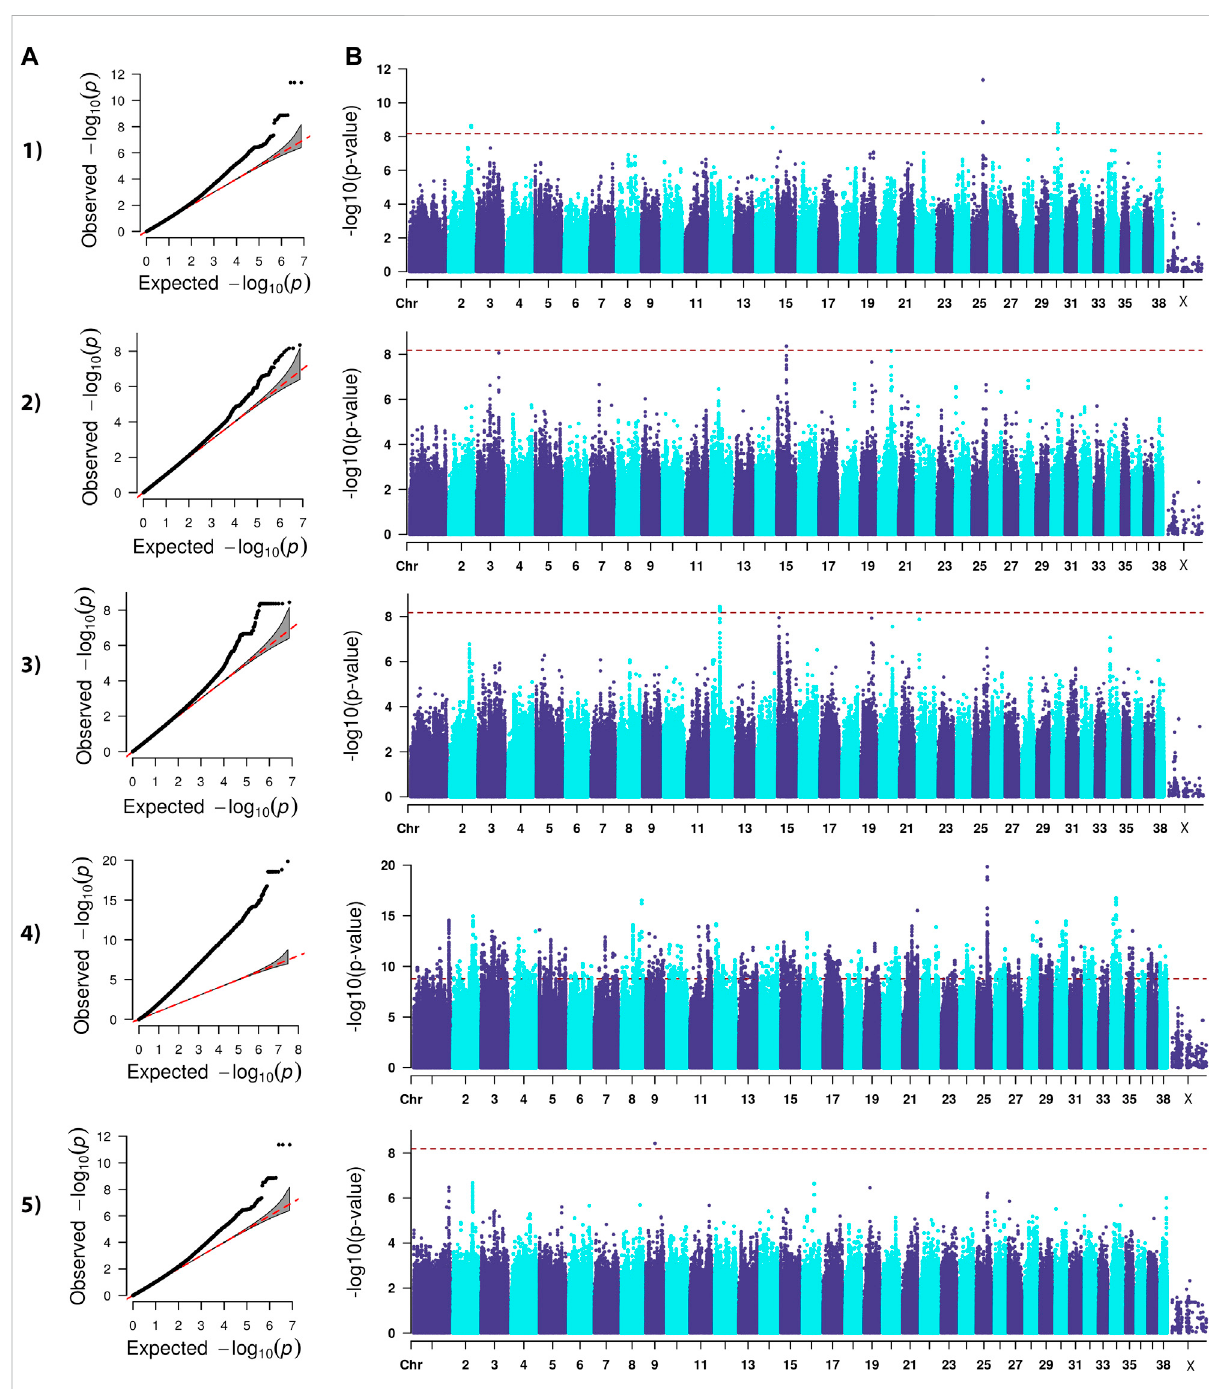
FIGURE 1 QQ (A) and Manhattan (B) plots. Comparison of four models for performing across-breed genome-wide association study using breed phenotypes for OFA hipdysplasia.1)Linearmixedmodel, λ =0.95, 16signi fi cantsingle-nucleotidepolymorphisms (SNPs) on chromosome2,14,25, and 30 ( p < 6.59E-9). 2) Stringent binary case-control model, λ = 1.034, 1 signi fi cant SNP on chromosome 15 ( p < 6.68E-9). 3) Lenient binary case- control model, λ = 1.02, 21 signi fi cant SNPs on chromosome 12 ( p < 6.64E-9). 4) Haplotype-based model, λ = 2.31, 5,687 signi fi cant SNPs with thestrongestassociationsoccurring on chromosomes 8, 21, 25, and 34( p < 1.68E-9). 5) Weighted leastsquares model, λ =1.54, 1 signi fi cantSNP on chromosome 9 met Bonferroni signi fi cance cutoff ( p <